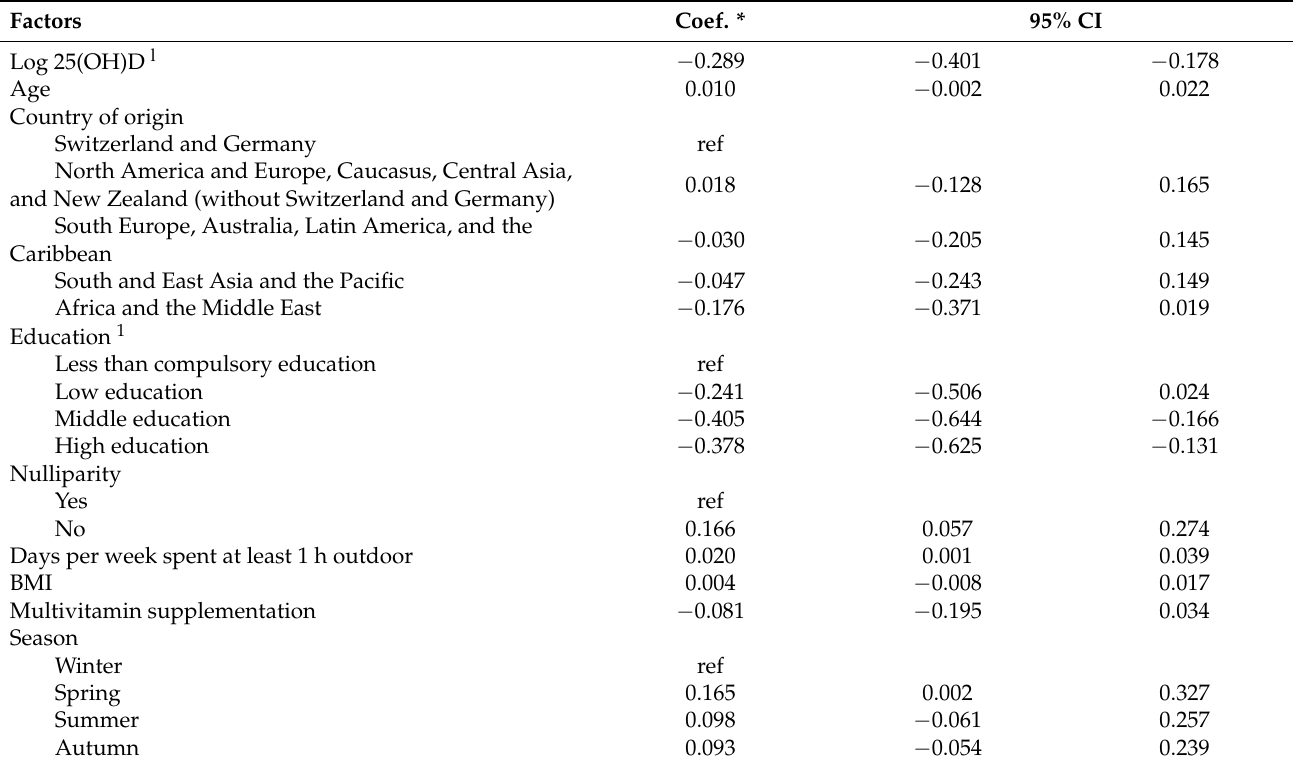
Table 2. Multiple regression analysis and determinants for log PTH concentrations in the 1st trimester. Factors Coef. * 95%